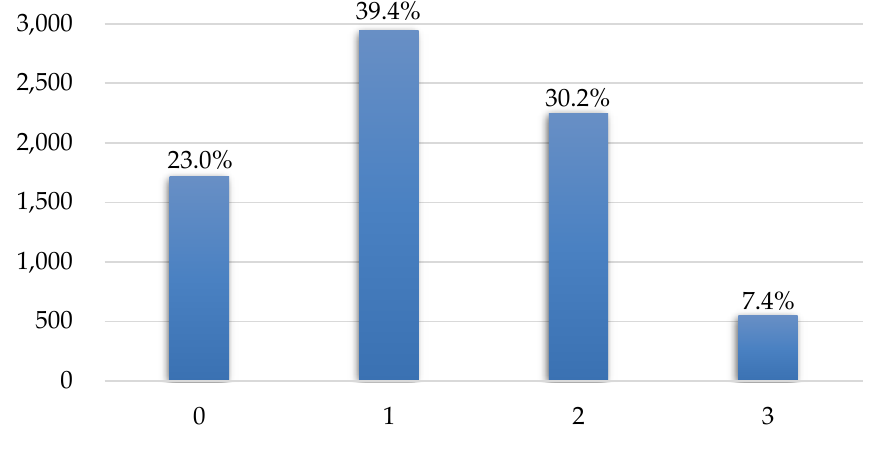
Figure 2. The number of participants in each FAFH category.